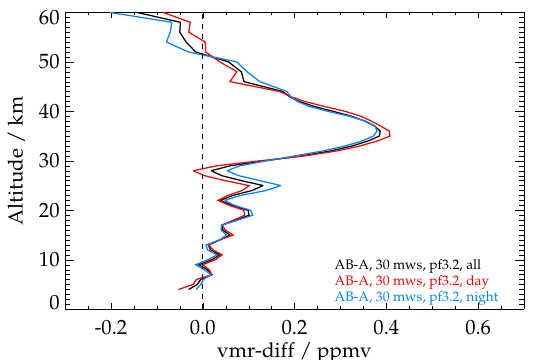
Figure 3. Difference between mean ozone profiles retrieved in MI- PAS channels AB and A using the MIPAS pf3.2 spectroscopy. The profiles are averages over 59 orbits from 3 January, 1 April, 2 July and 2–3 October 2009 for all (black), daytime (red) and night-time profiles (blue).